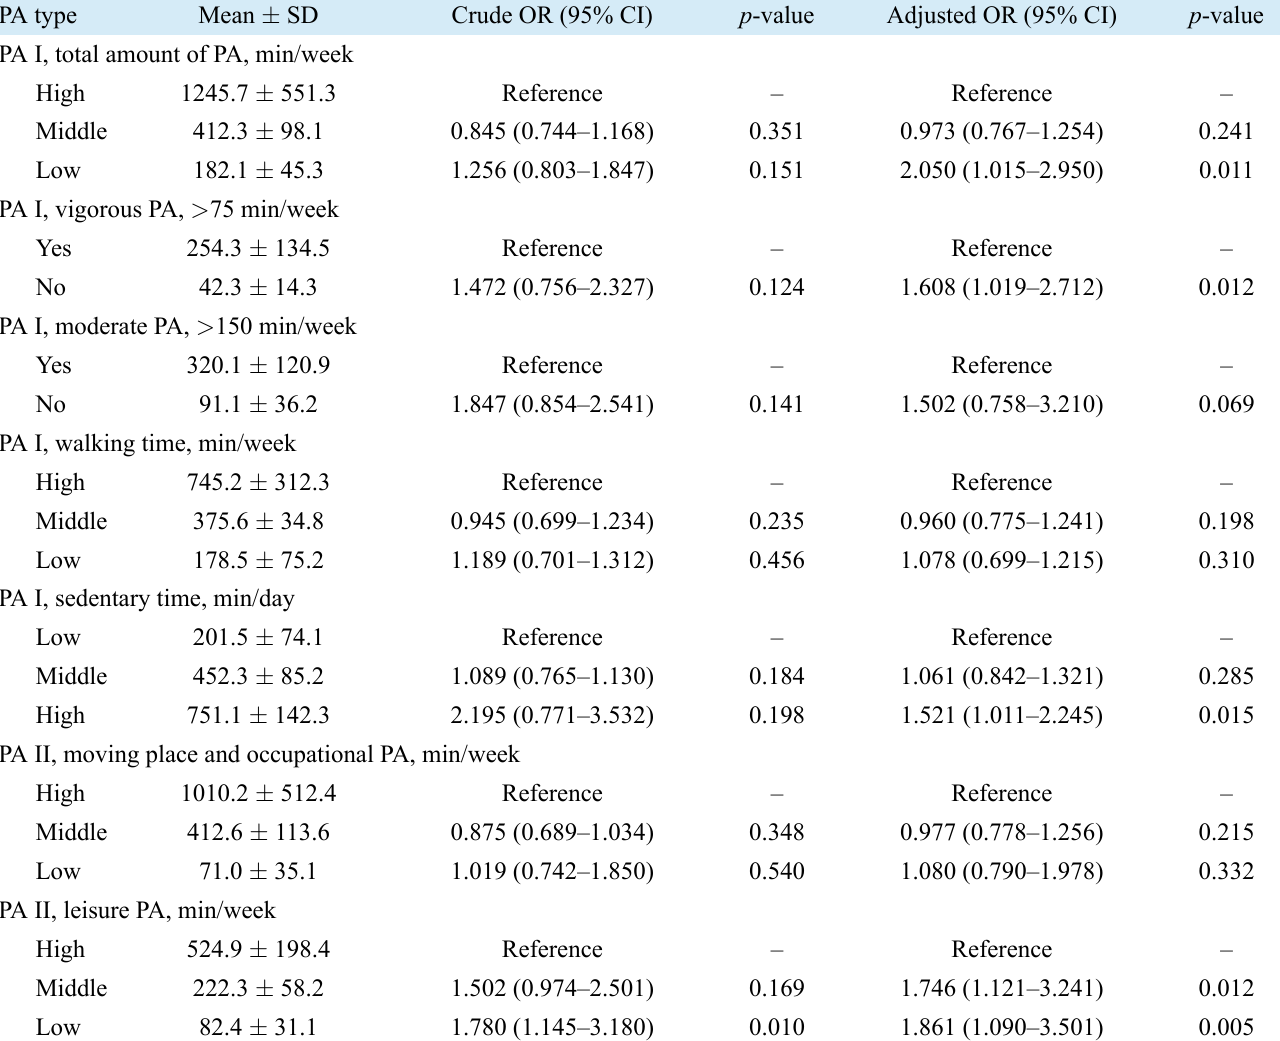
TABLE 3. Odds ratio of MUNW for physical activity and sedentary time in normal